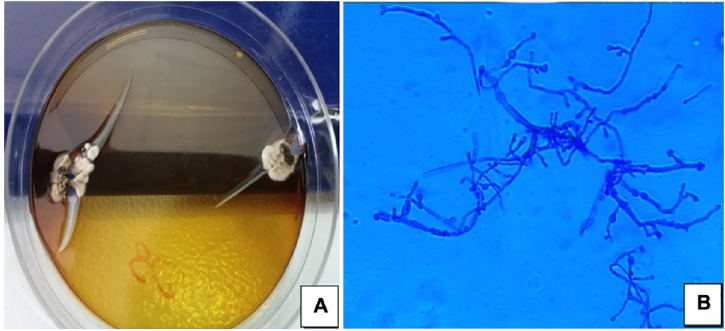
Fig 2. Culture on Sabouraud dextrose agar showing flat and dry colonies adhering to the agar, white to yellowish brown in colour, slightly folded with a brown diffusible pigment (A) and microscopic features of the colonies showing a sterile mycelium composed of septate hyphae with several chlamydospores (B).